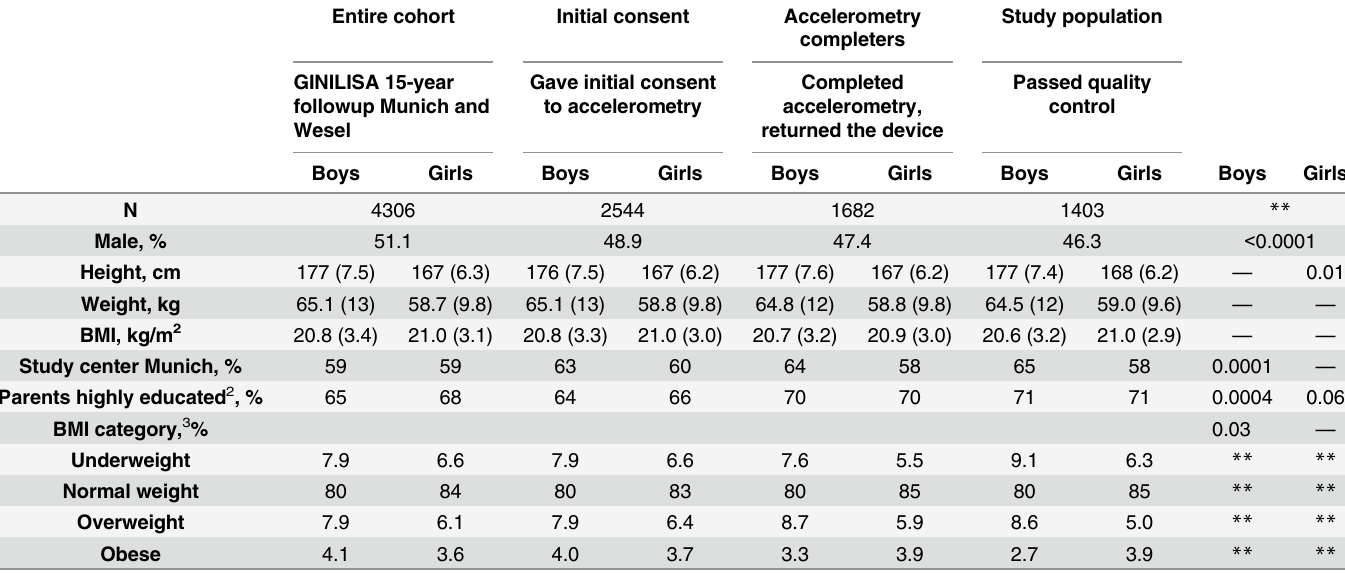
Table 1. Population Characteristics/ Selection Bias within GINIplus and